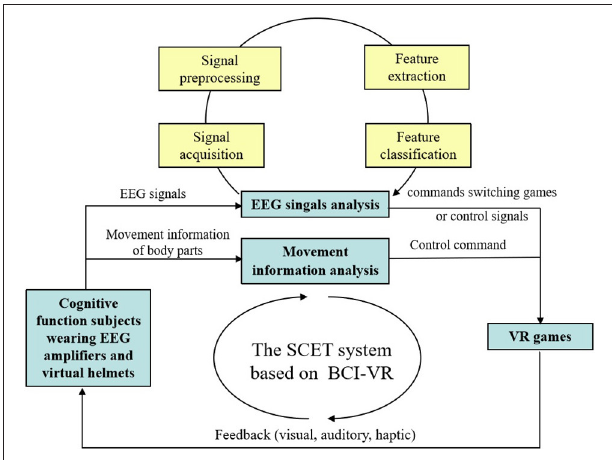
FIGURE 1 | The schematic diagram for the system description of the SCET with